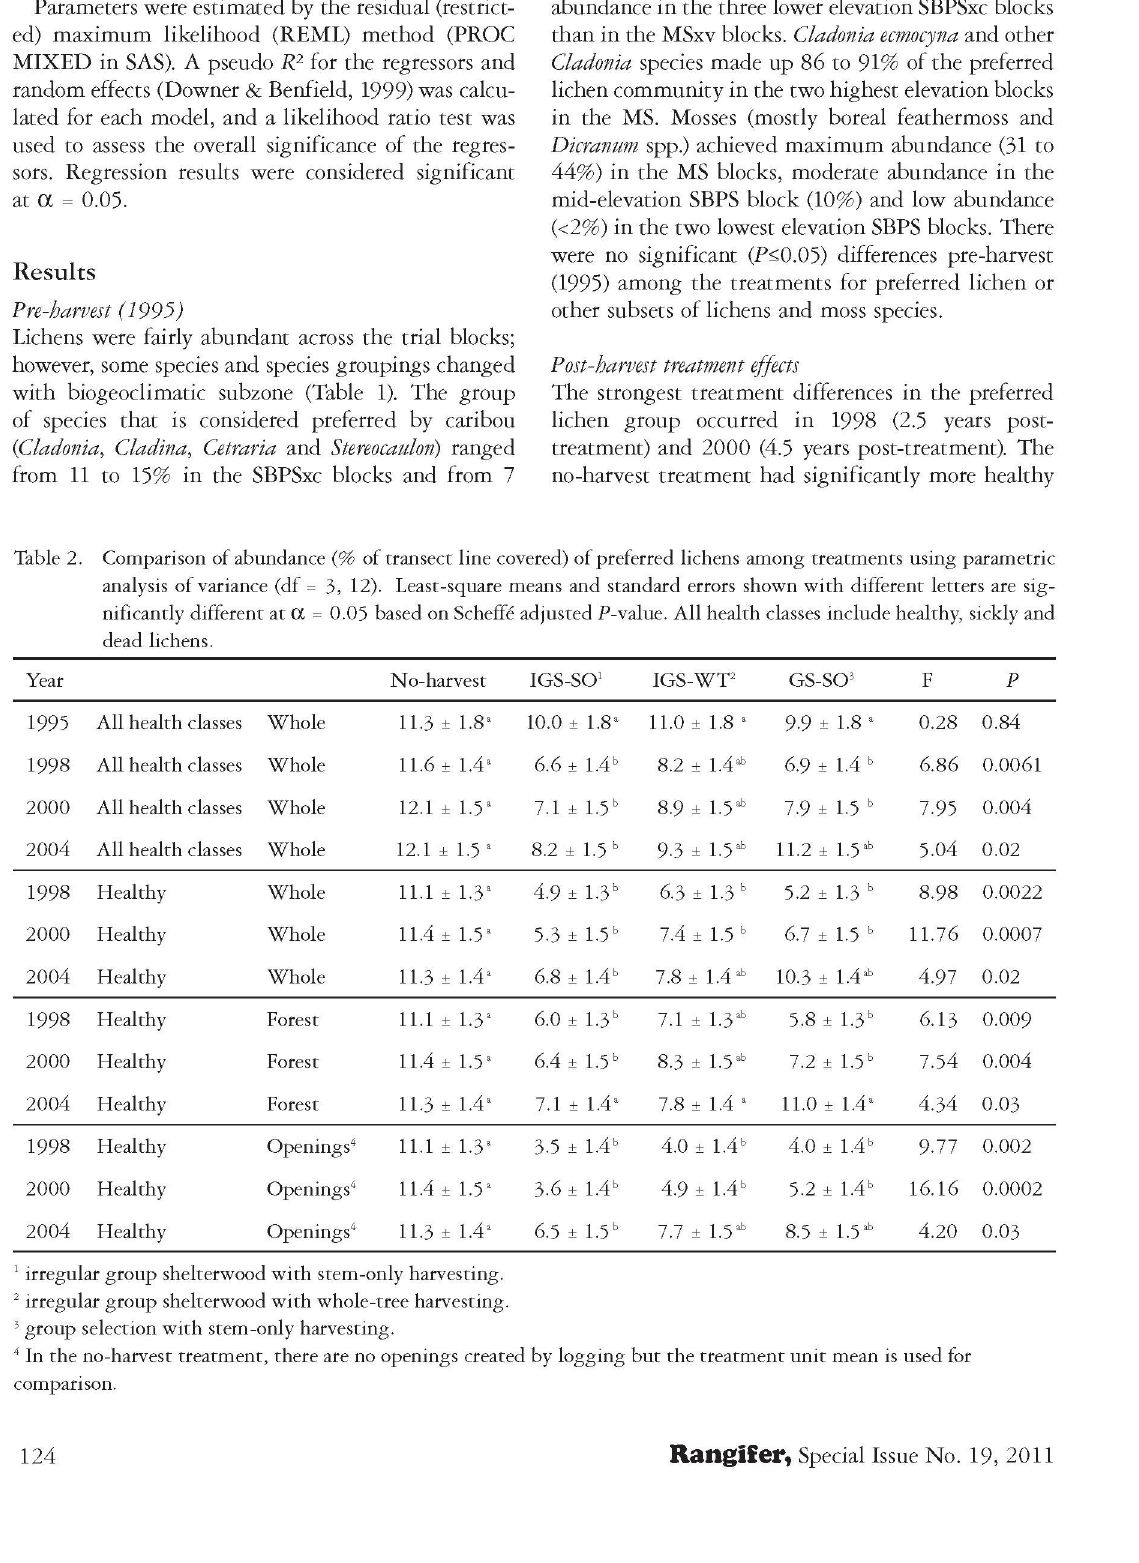
Table 2. Comparison of abundance (% of transect line covered) of preferred lichens among treatments using parametric analysis of variance (df = 3, 12). Least-square means and standard errors shown with different letters are sig¬ nificantly different at a = 0.05 based on Scheffe adjusted P-value. All health classes include healthy, sickly and dead